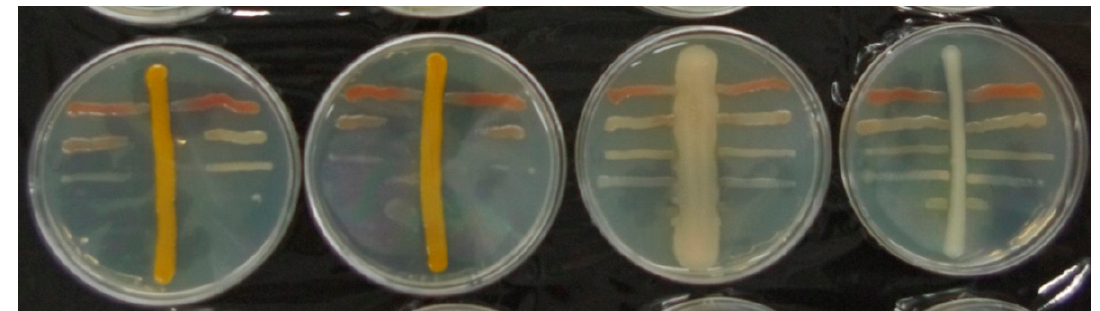
Figure 1. Cross-streak tests between A. solstitiale midgut isolates and EPN symbionts. Horizontal streaks– Xenorhabuds or Photorhabdus , vertical streak–midgut isolate. Plates on the left-isolates with high antibacterial activity against EPN bacteria strains ( Chryseobacterium sp.); plates on the right-no inhibition effect. Table 1. Cross-streak tests between selected A. solstitiale midgut isolates and five EPN symbionts. Size of Inhibition Zones (mm) Left Inhibition Zone|Right Inhibition Strain ID *